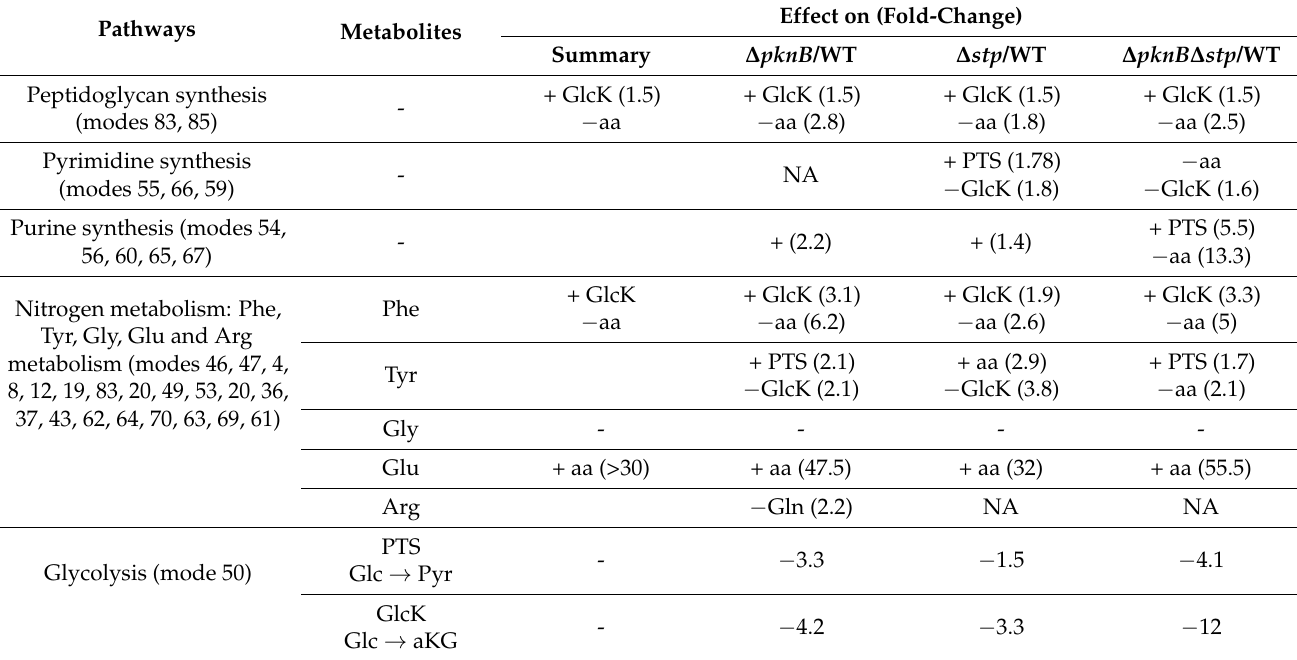
Table 1. Significantly up- and downregulated pathways in S. auerus NewHG, pknB and stp mutants 1 . Pathways Metabolites